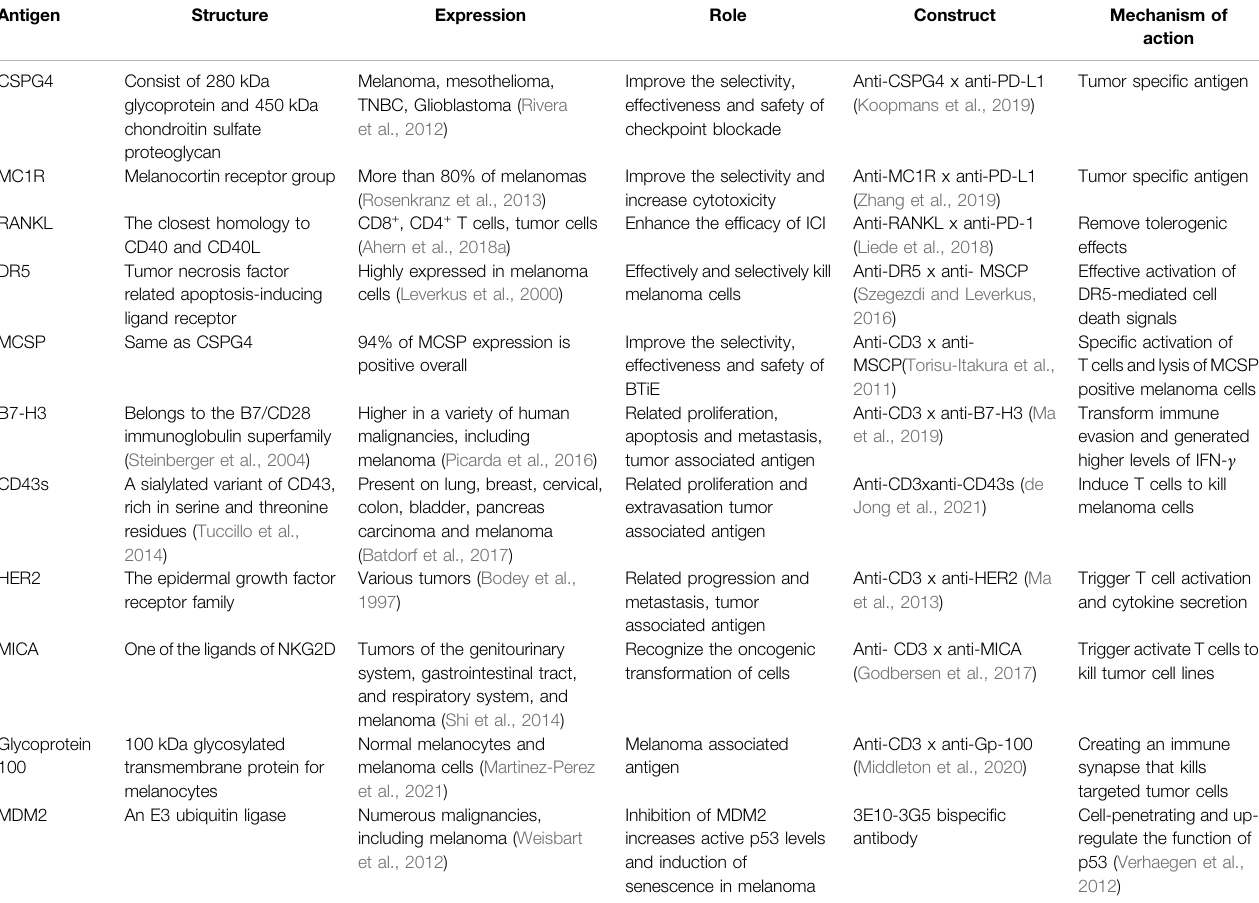
TABLE 1 | Melanoma cell related markers in bispeci fi c antibody pre-clinical